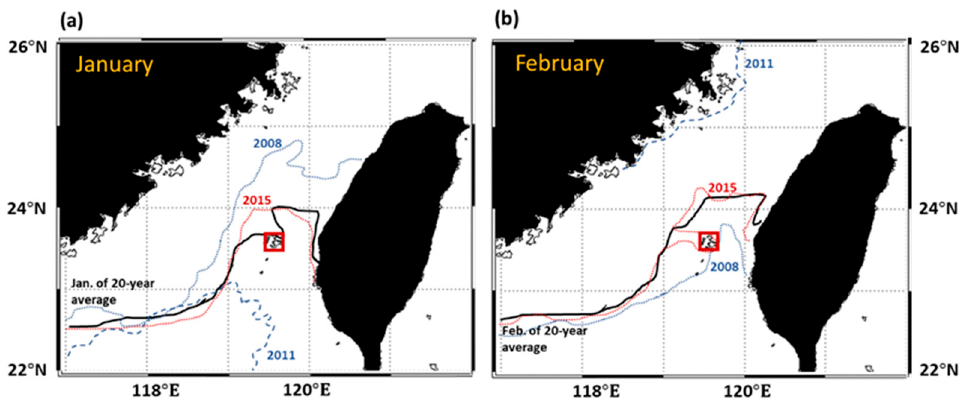
Figure 4. Contours of 20 ◦ C isotherms of ( a ) 13-year average (black line), El Niño events average (red lines), and La Niña events average (blue lines) during January, and ( b ) 13-year average (black line), El Niño events (red lines), and La Niña events (blue lines) during February. The red box indicates the study area of the Penghu Islands. Table 2. The result of reclassification by strong speed wind days. Category A (the strong speed wind